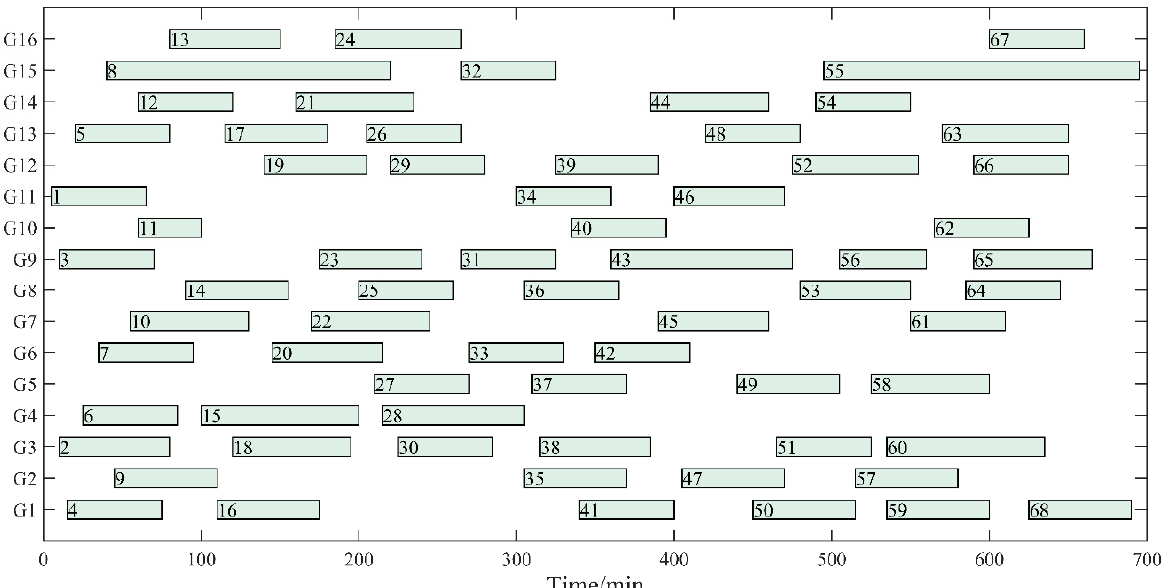
Figure 6. Gantt chart of the NSGA-II algorithm gate assignment solution.